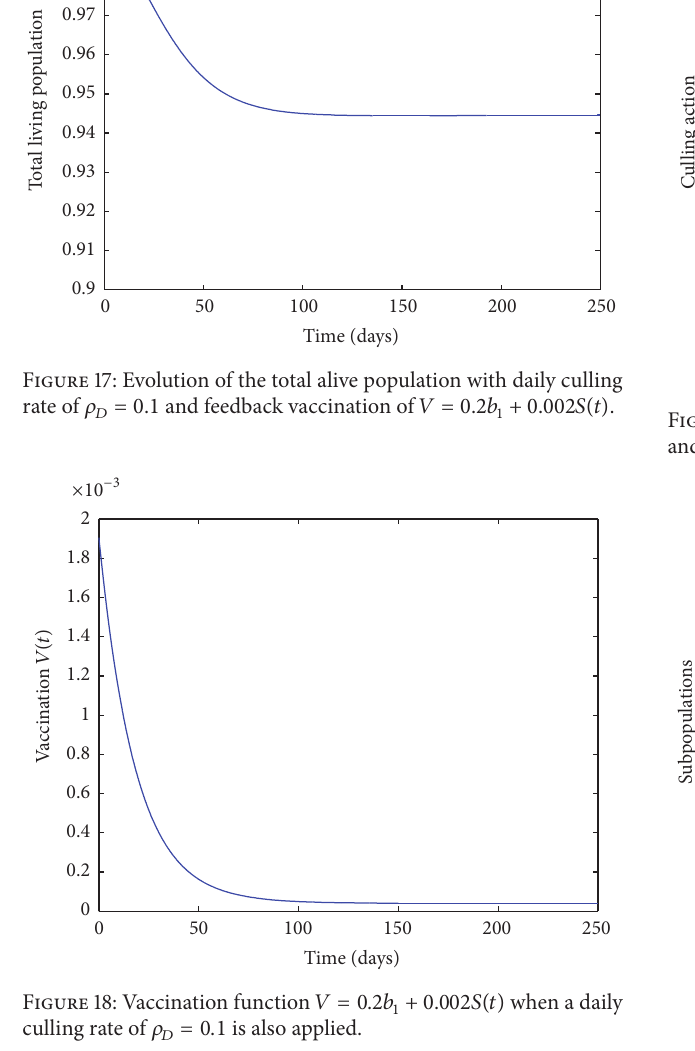
+ 0.002𝑆(𝑡) , and antiviral 1